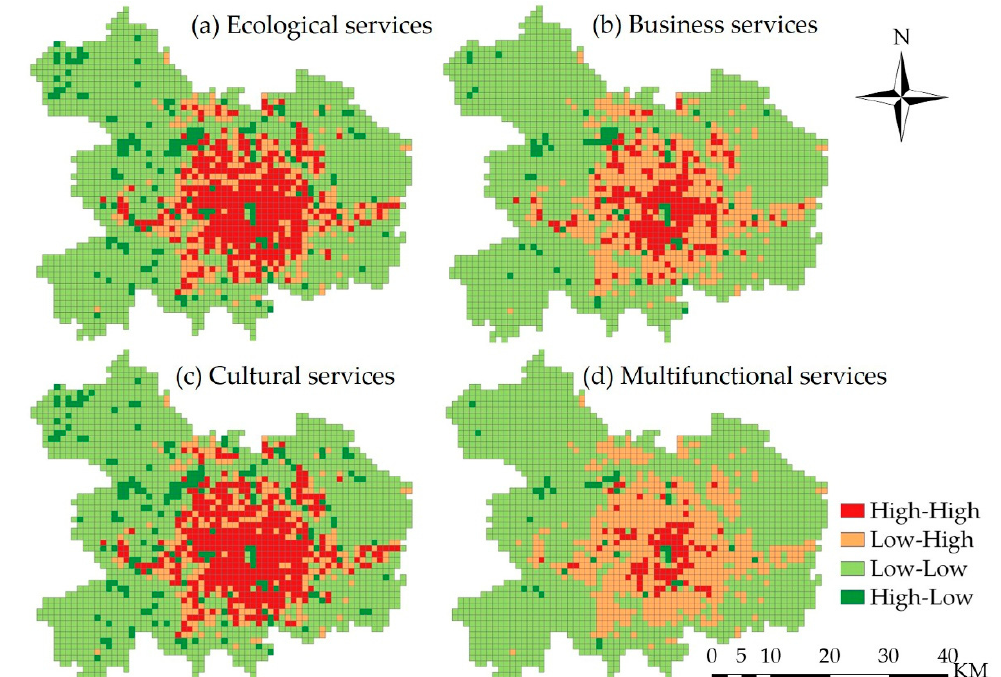
Figure 6. Distribution of supply–demand patterns of LSs in Beijing, China.